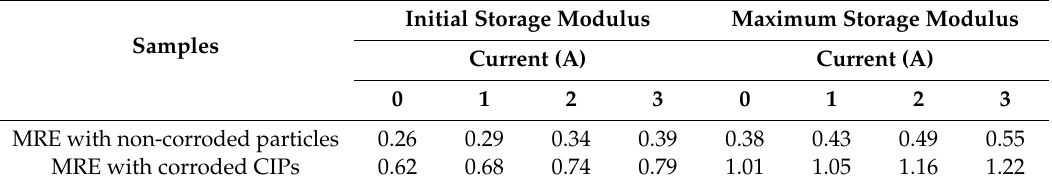
Table 3. Initial and maximum storage modulus of MRE samples with non-corroded and corroded CIPs. Samples